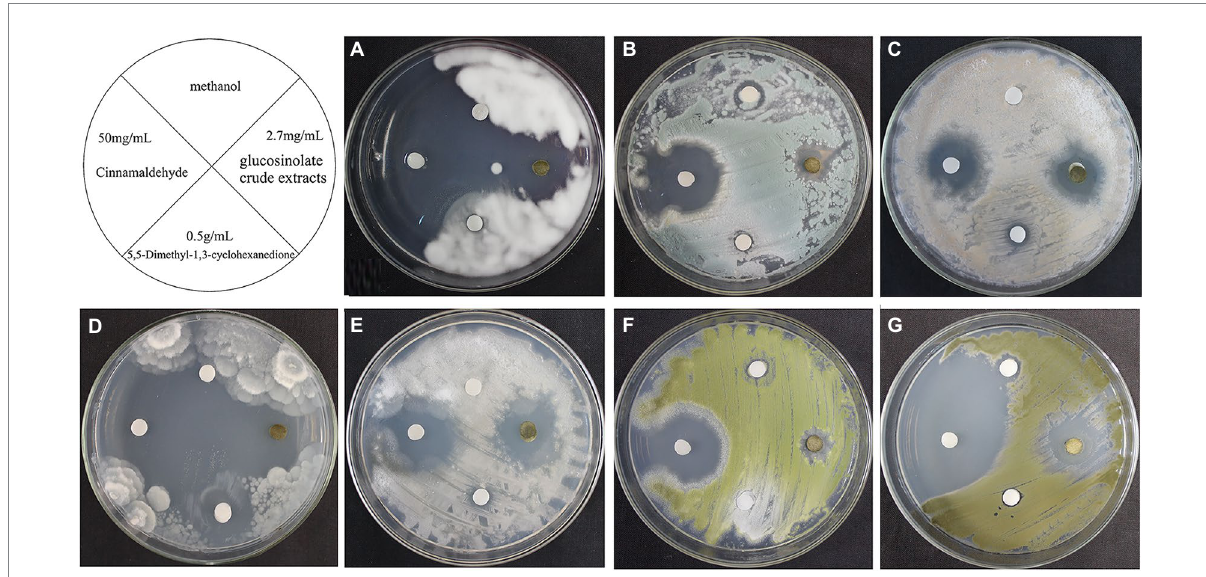
FIGURE 7 The fungistatic effects of 50 mg/ml Cinnamaldehyde, 2.7 mg/ml Glucosinolate crude extracts, and 0.5 g/ml 5,5-Dimethyl-1,3-cyclohexanedione. The fungi were inoculated onto the PDA medium and incubated at 28 ° C for 3 days. (A) L. aphanocladii (NK-PF1). (B) P. aurantiogriseum (NK-PF2). (C) C. rosea (NK-PF3). (D) Mortierella sp. (NK-PF4). (E) M. alpina (NK-PF5). (F) A. flavus (NK-PF6). (G) C. halotolerans